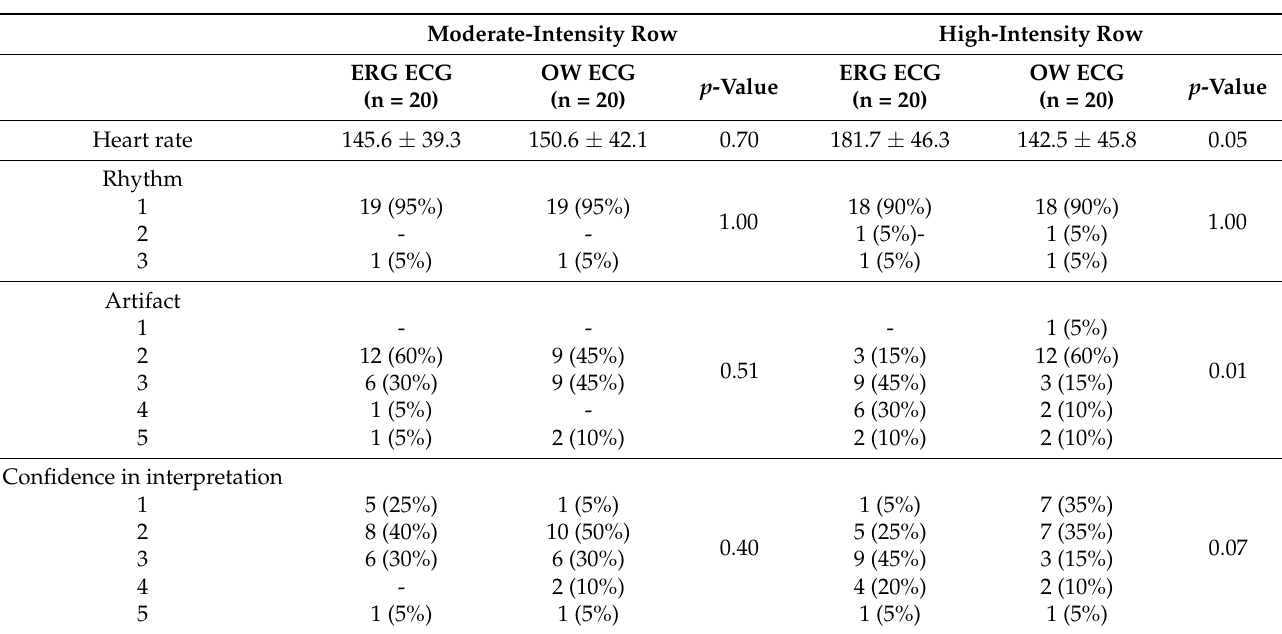
Table 3. Differences between Erg and OW ECGs for moderate and high-intensity exercise using consensus data from ECG